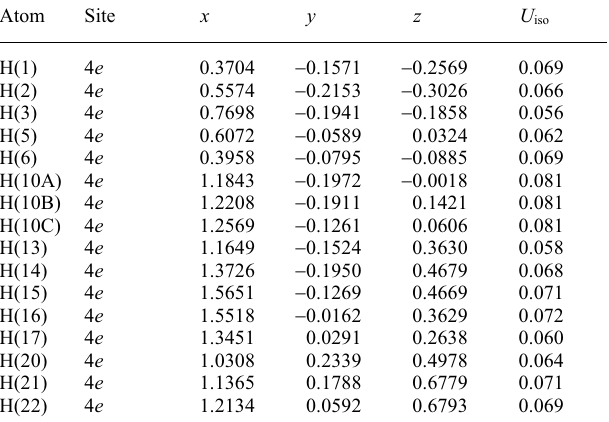
Table 2. Atomic coordinates and displacement parameters (in Å 2 )